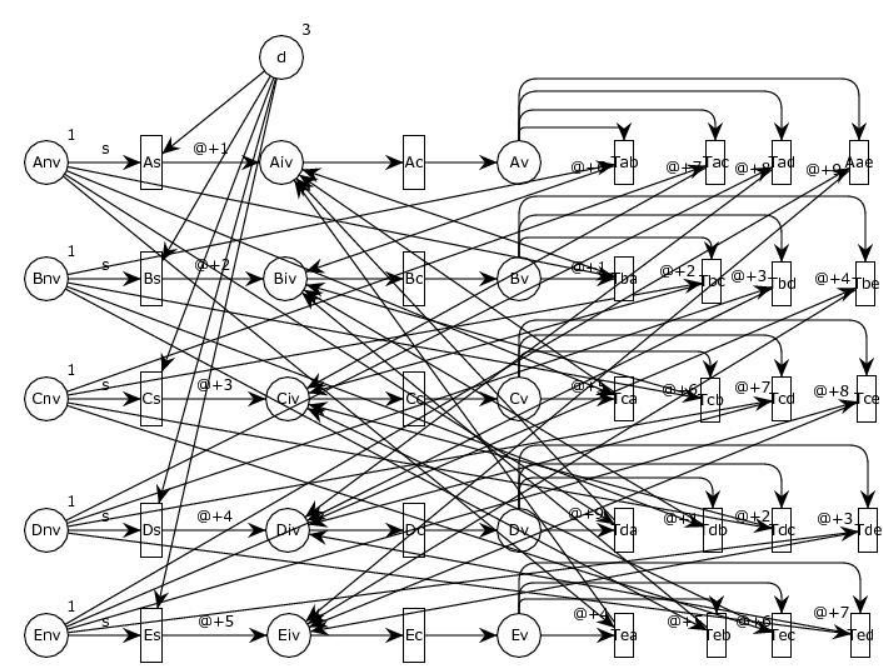
Figure 10. mTSP involving five connected cities, a depo and three salesmen with asymmetric cost matrix. Figure 11. mTSP involving five connected cities, a depo and three salesmen with symmetric cost matrix.